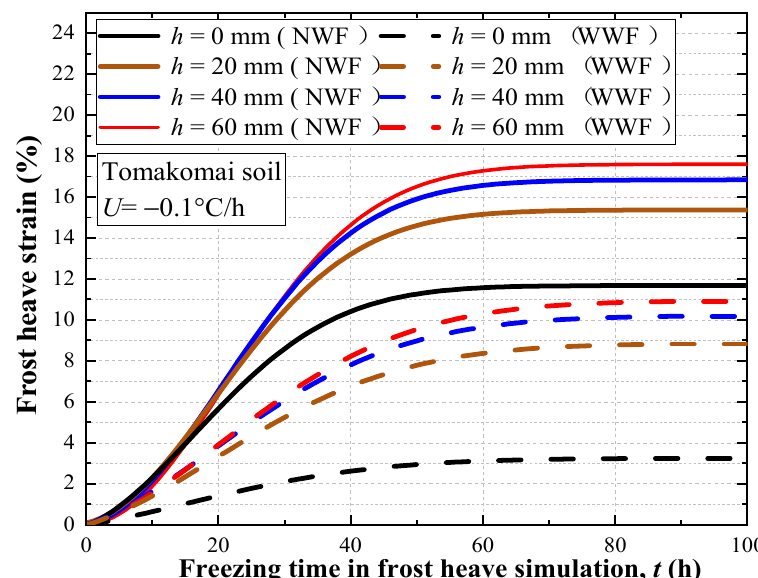
Figure 12. Effect of GWL on frost heave and WF inhibiting effect.